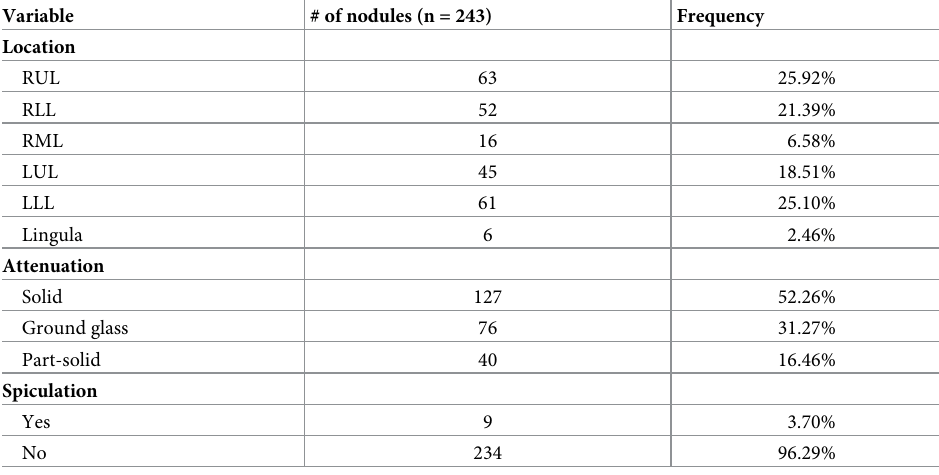
Table 2. Lung nodules cohort features distribution.